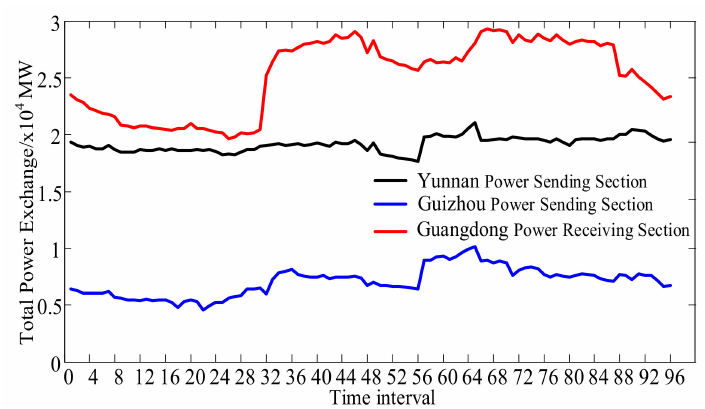
Figure 2. Main grid structure of the AC-DC interconnected power grid.